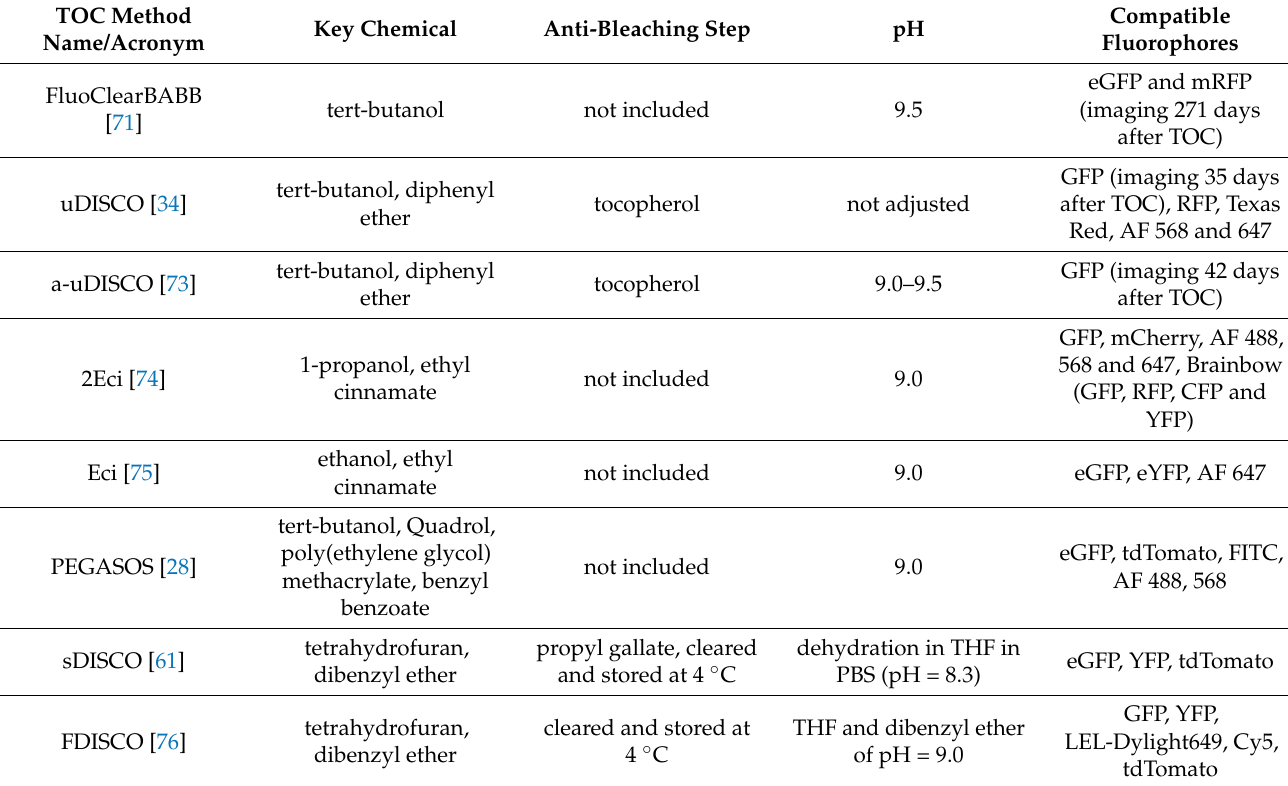
Table 3. List of solvent-based TOC methods that stabilize